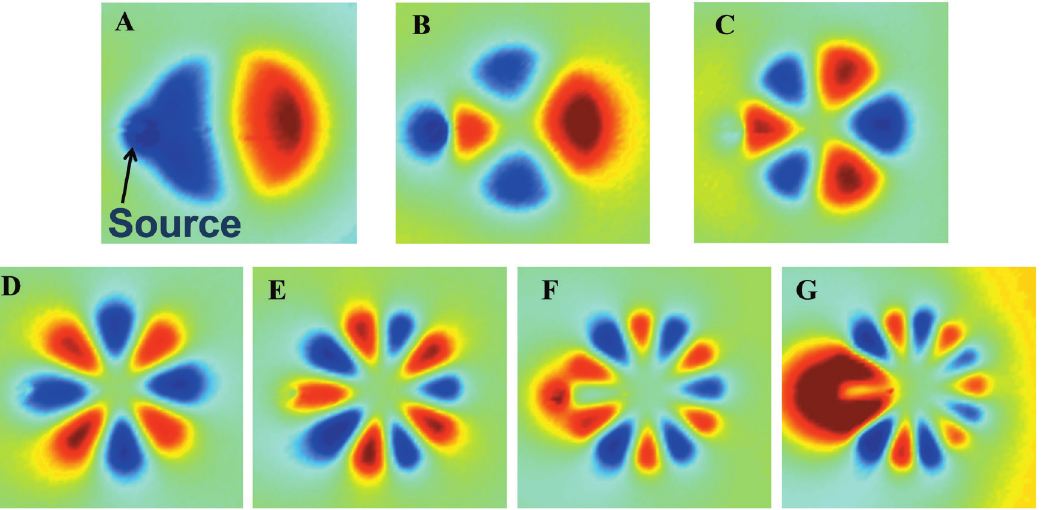
Figure 23: The measured near-field patterns of vertical electric fields on a plane 0.5 mm above the textured metallic disk. (A) Dipole mode (M ) at 4.52 GHz; (B) quadrupole mode (M 1 pole mode (M ) at 8.08 GHz; (F) dodecapole mode (M 5